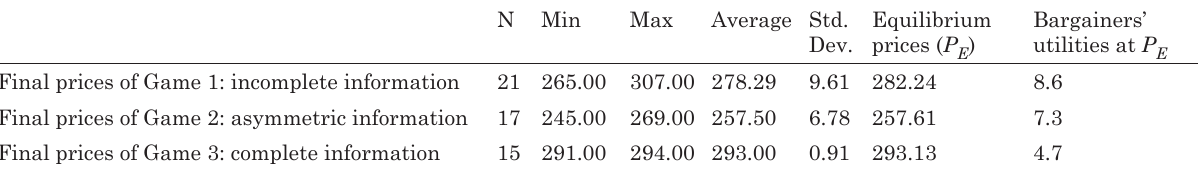
N Min Max Average Std.